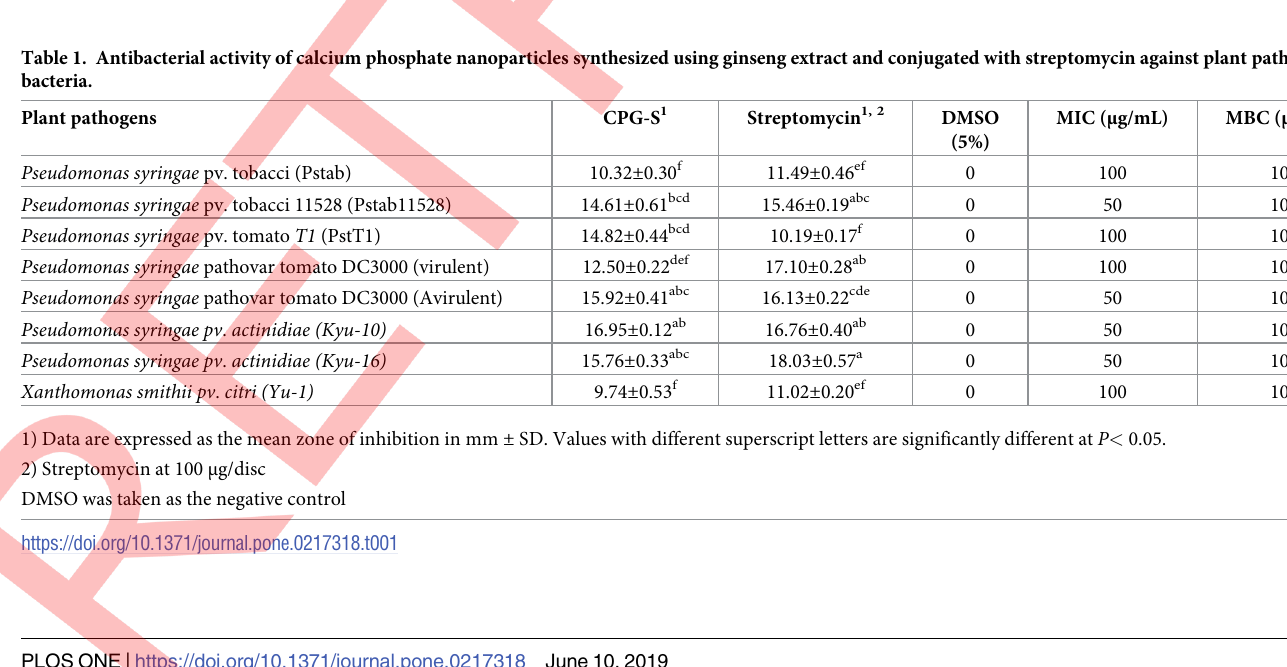
Fig 5. TG/DTG spectra of the synthesized CPG-S NPs.